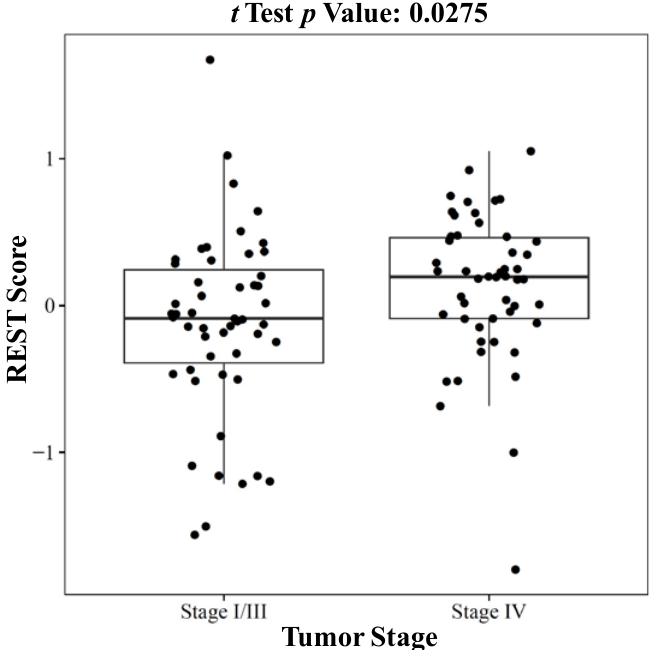
Figure 4. Clinical relevance of the REST signature in neuroblastoma patients. Patients in late stage (stage IV) had higher REST scores (ANOVA test p value = 0.0275) than those in early stages. Of note, there were no Stage II patients in this